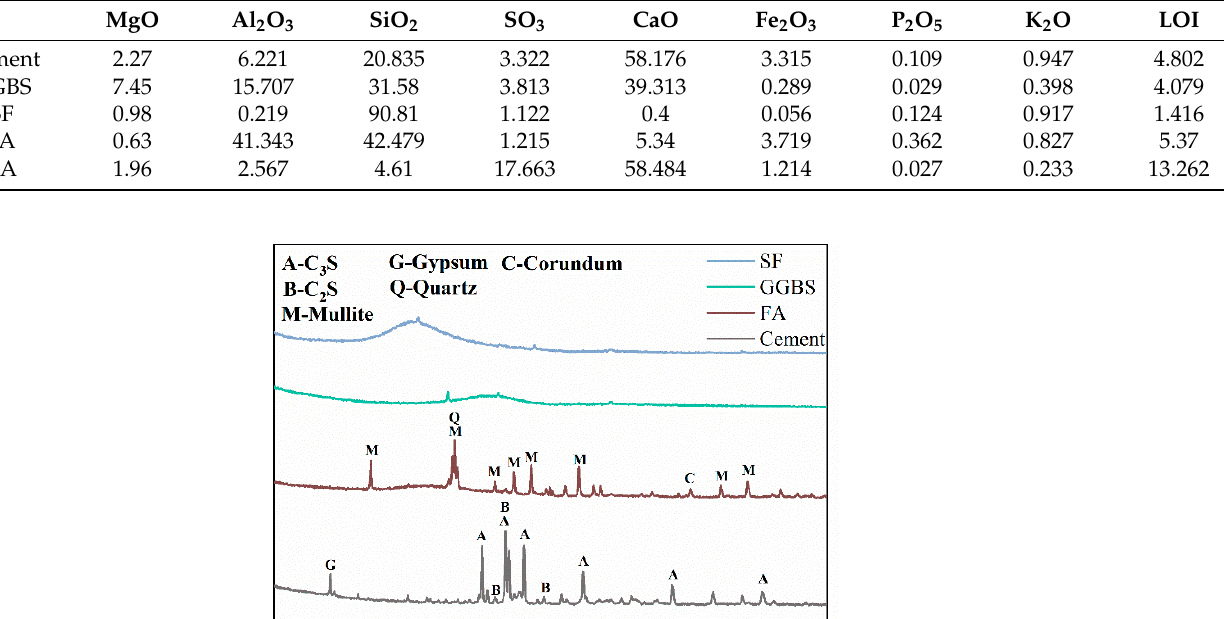
Table 1. Chemical composition of materials (%).